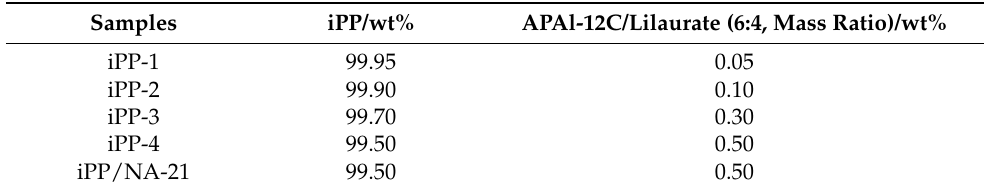
Table 1. The formula of the iPP/A12C-Li composites.